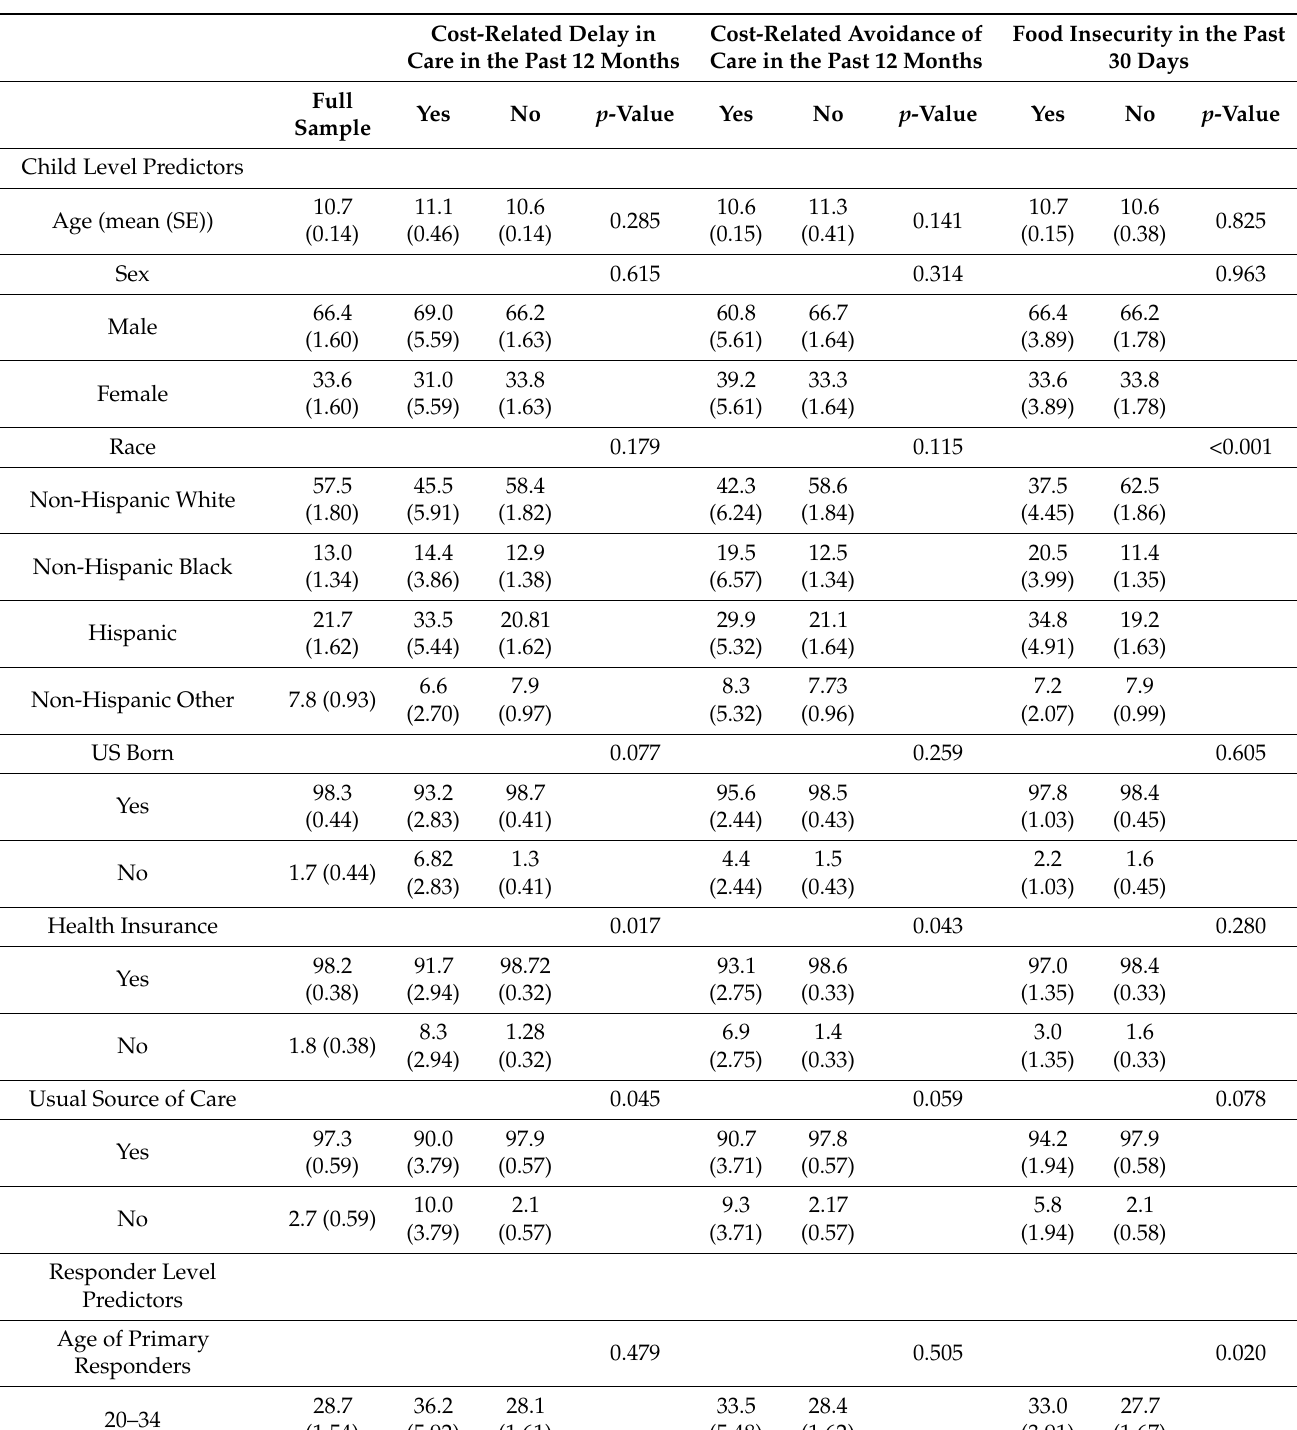
Table 1. Univariate Analysis of Unmet Medical Needs and Food Insecurity with Social demo- graphic